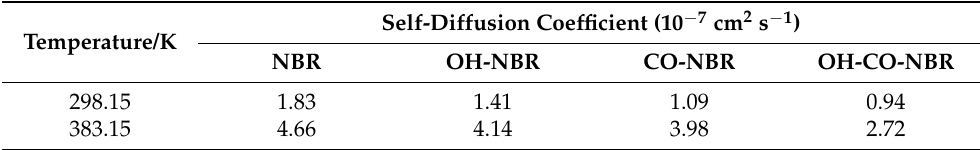
Table 2. The self-diffusion coefficients of unaged and aged NBR chains under different conditions.